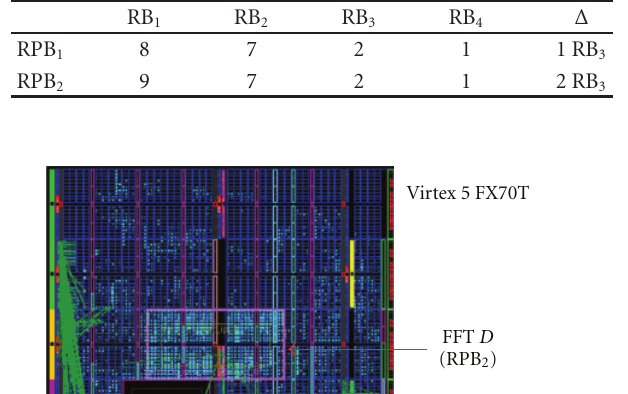
Table 4: Resource e ffi ciency.